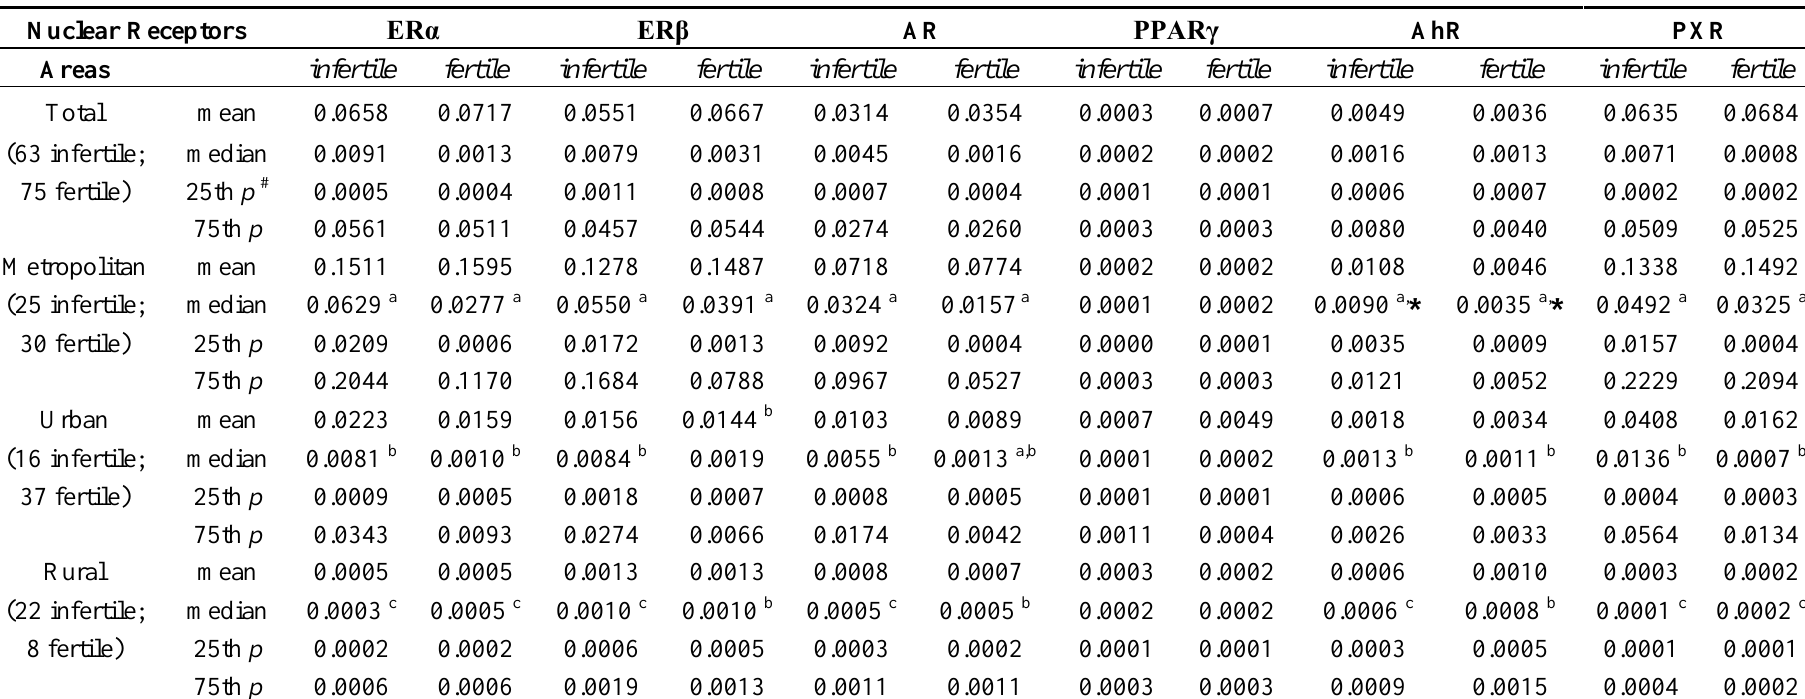
Table 5. Gene expression values of nuclear receptors in enrolled men grouped by area of residence and subject group. Data are expressed as 2 −ΔCt values with GAPDH as reference